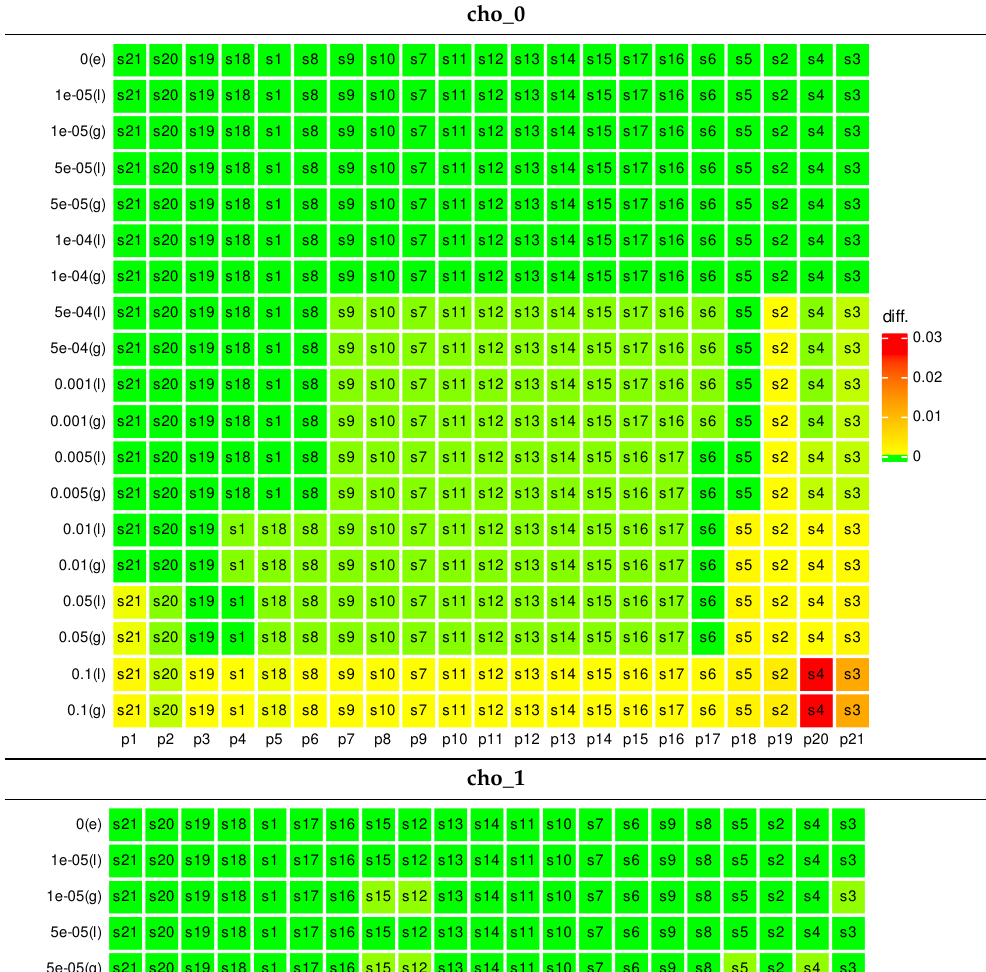
Table 19. Preferences for cho_0 and cho_1